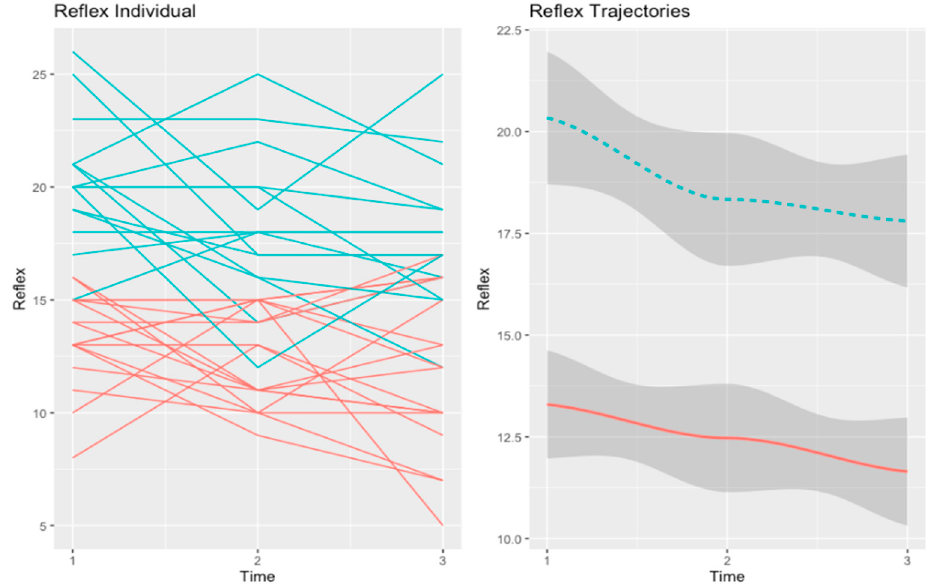
Figure 3. Trajectories of self-reflectivity in the psychoeducation group. The red line refers to the “Low-SR” trajectory (n = 18). The second trajectory (in blue), refers to the “Worsening-SR” (n = 16) trajectory. Concerning self-reflectivity, the first trajectory (in red), henceforth “Low-SR” (n = 18), included patients that had a low baseline level of self-reflectivity. In this trajectory, self- reflectivity consistently declined over time. The second trajectory (in blue), henceforth “Worsening-SR” (n = 16), comprised patients exhibiting self-reflectivity that was high at baseline but declined steeply over